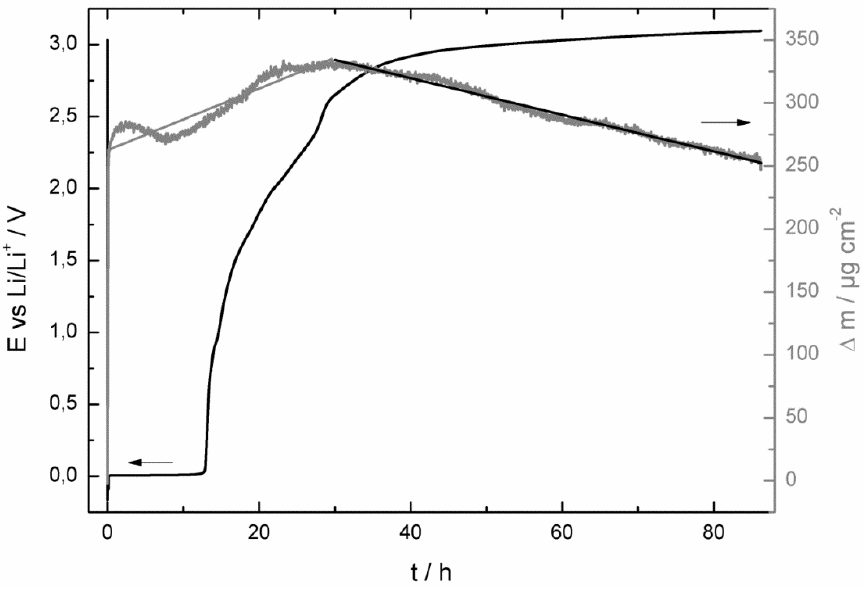
Figure 2. Time dependence of potential and attributed mass change during the OCP measurement after lithium was deposited on copper in 1 M LiPF